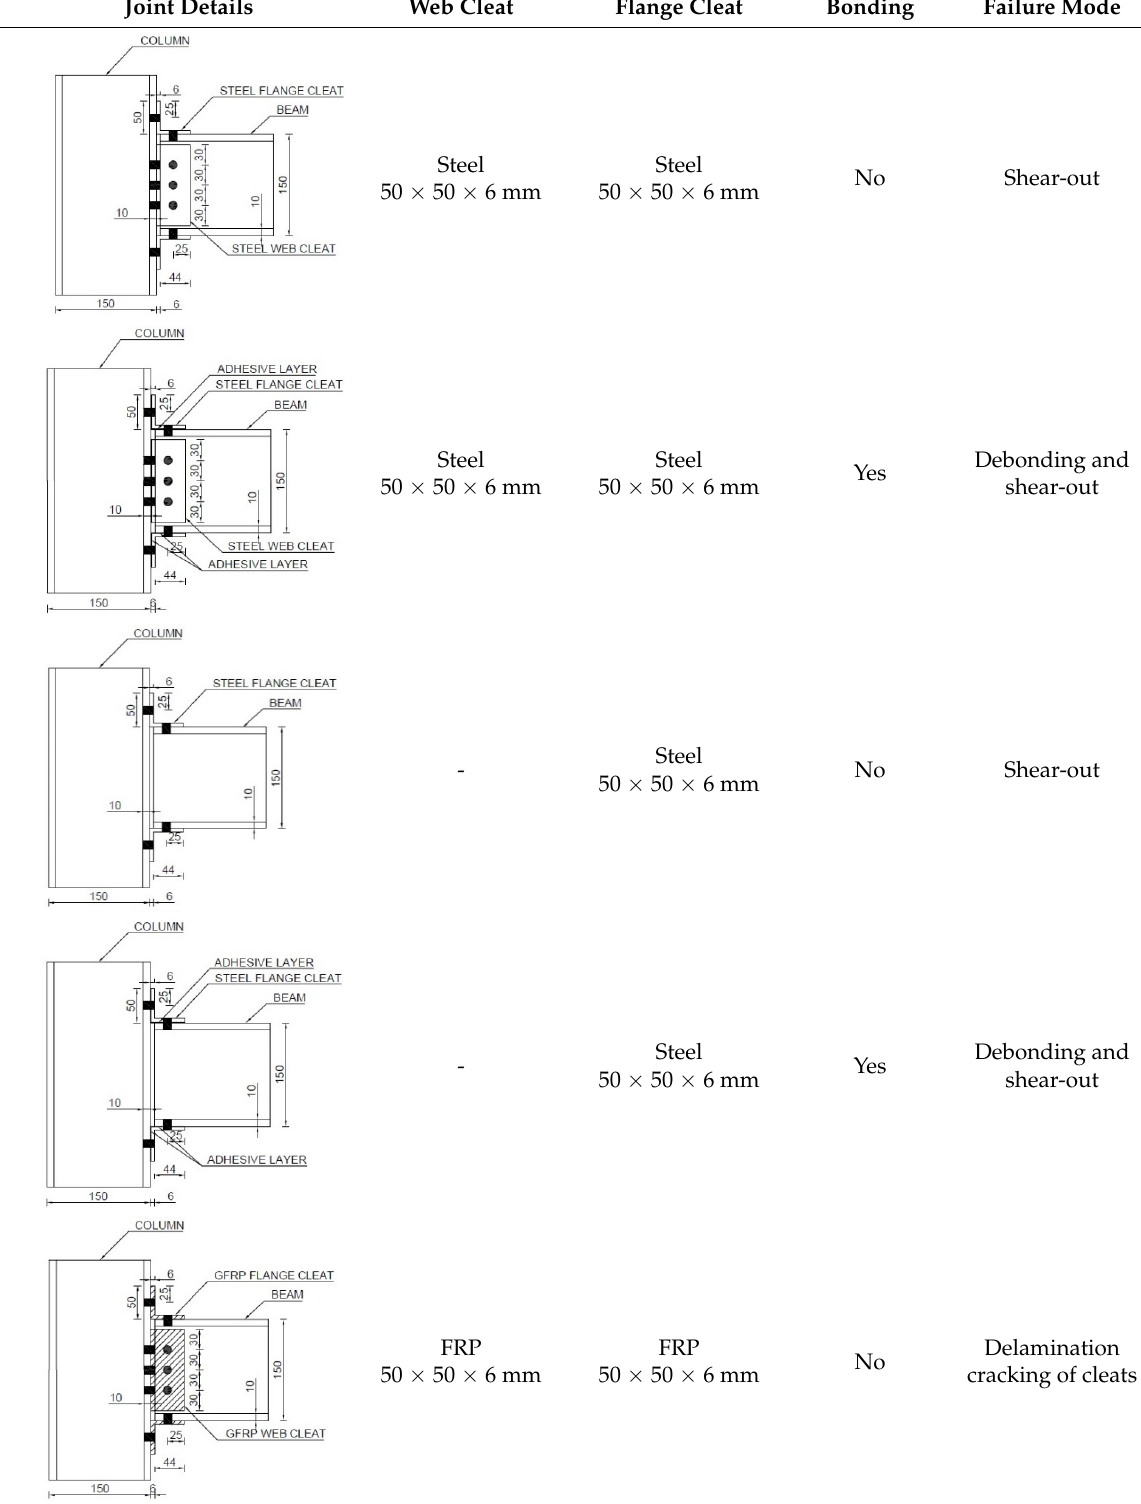
Table 2. Joint configuration and detailing.